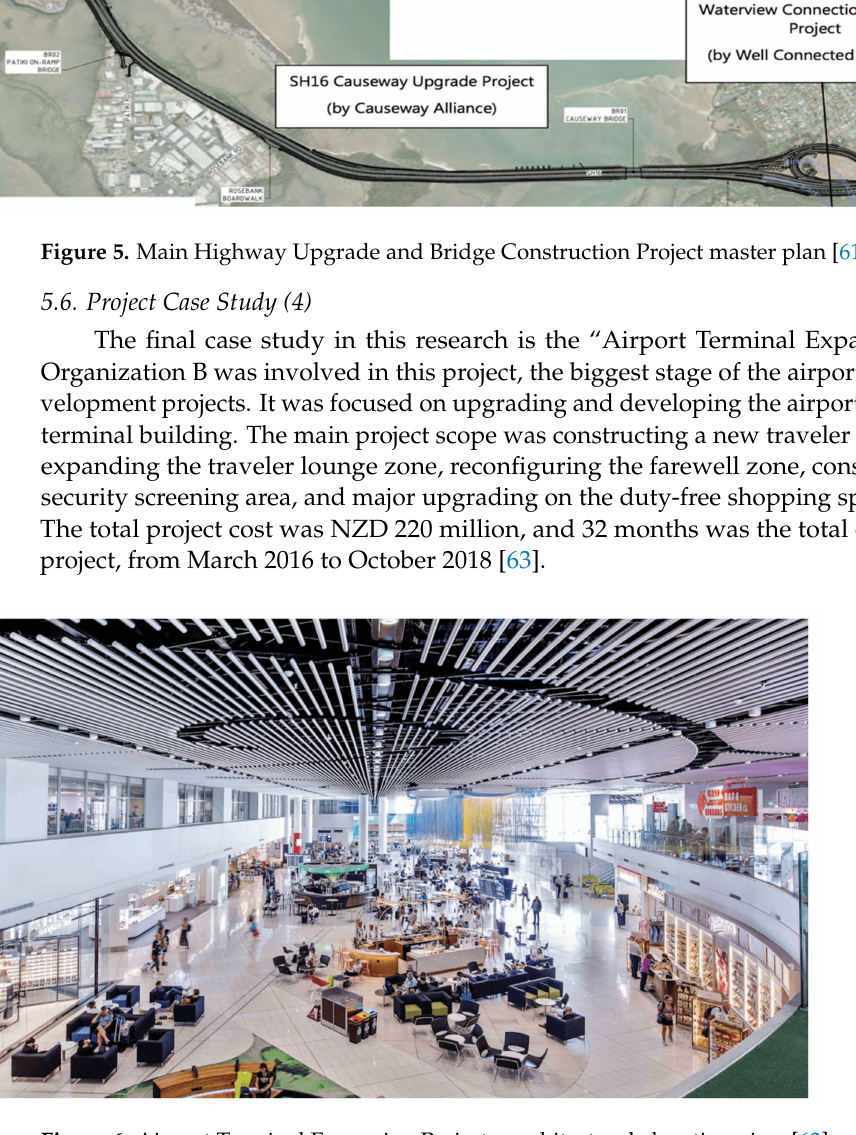
Figure 6. Airport Terminal Expansion Project—architectural elevation view